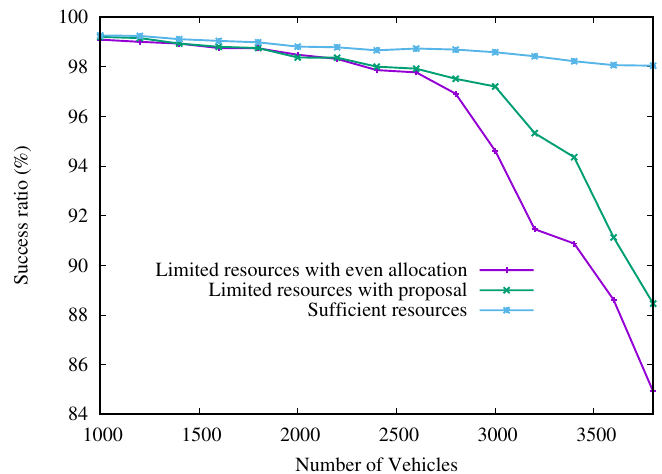
Figure 8. Success ratio performance of the system without coexisting tasks.